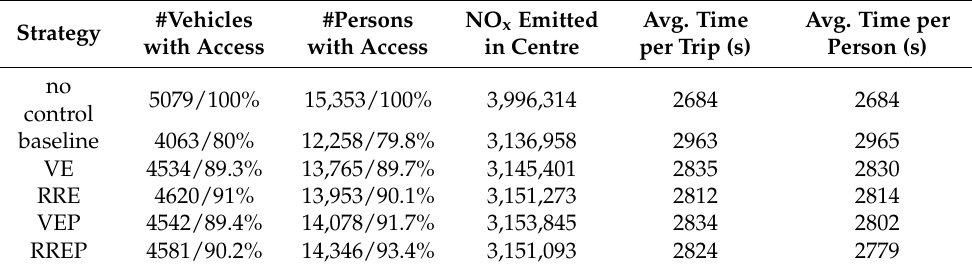
Table 3. Simulation results for pollution-based access with constant arrival